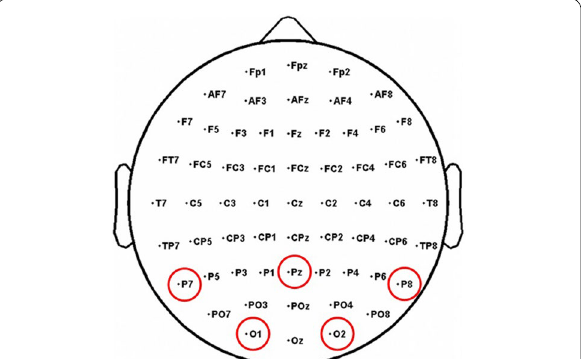
Fig. 2 Repartition of the electrodes on the scalp